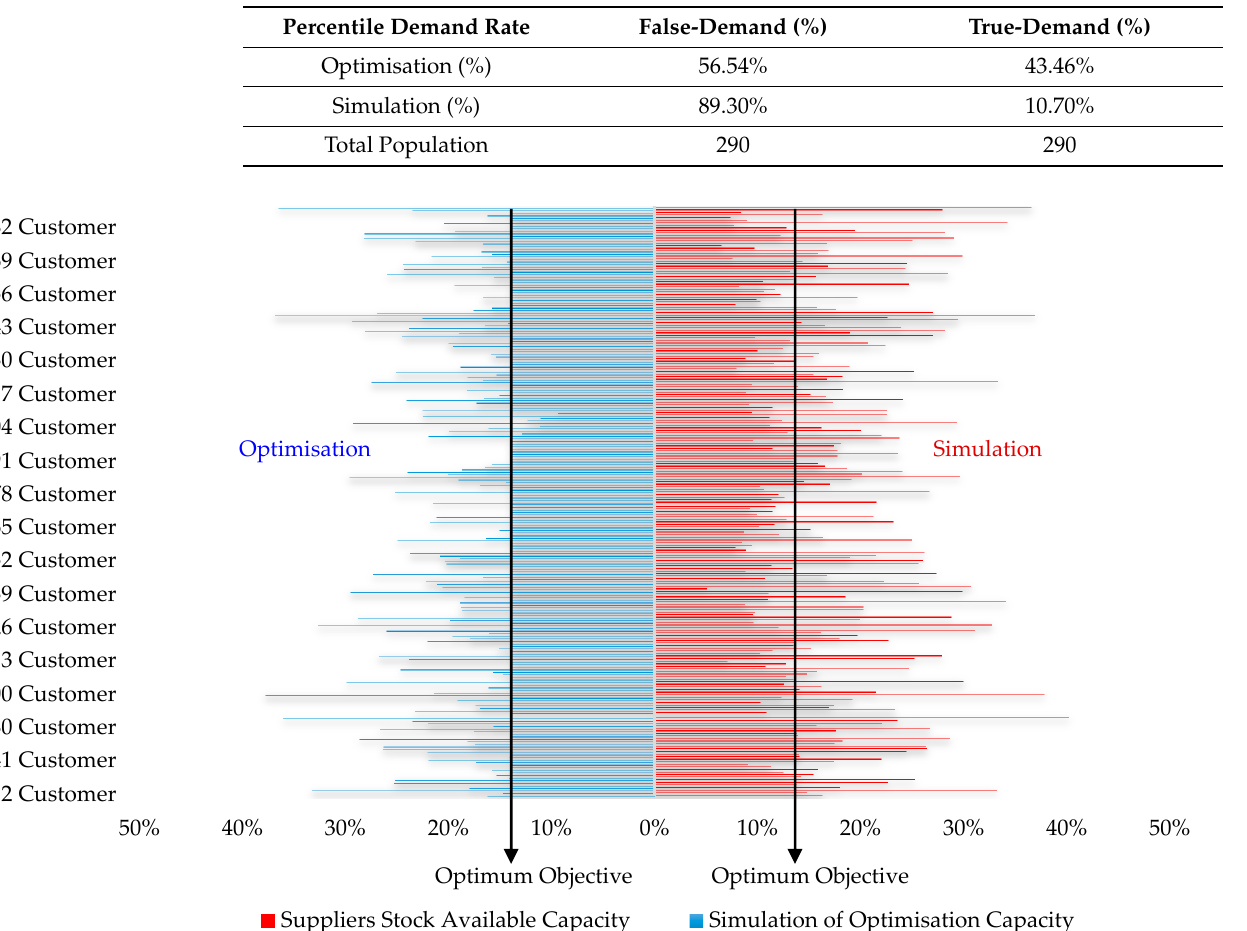
Table 5. Summary of Data Simulation and Optimisation Analysis.